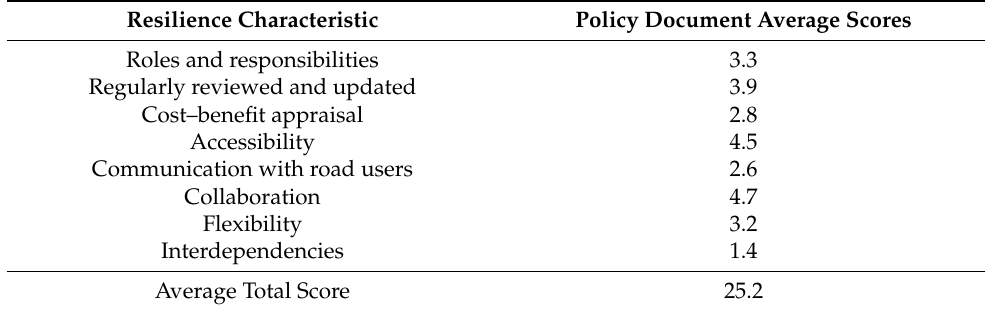
Table 4. Overview of results of the evaluation of policy documents by assessment